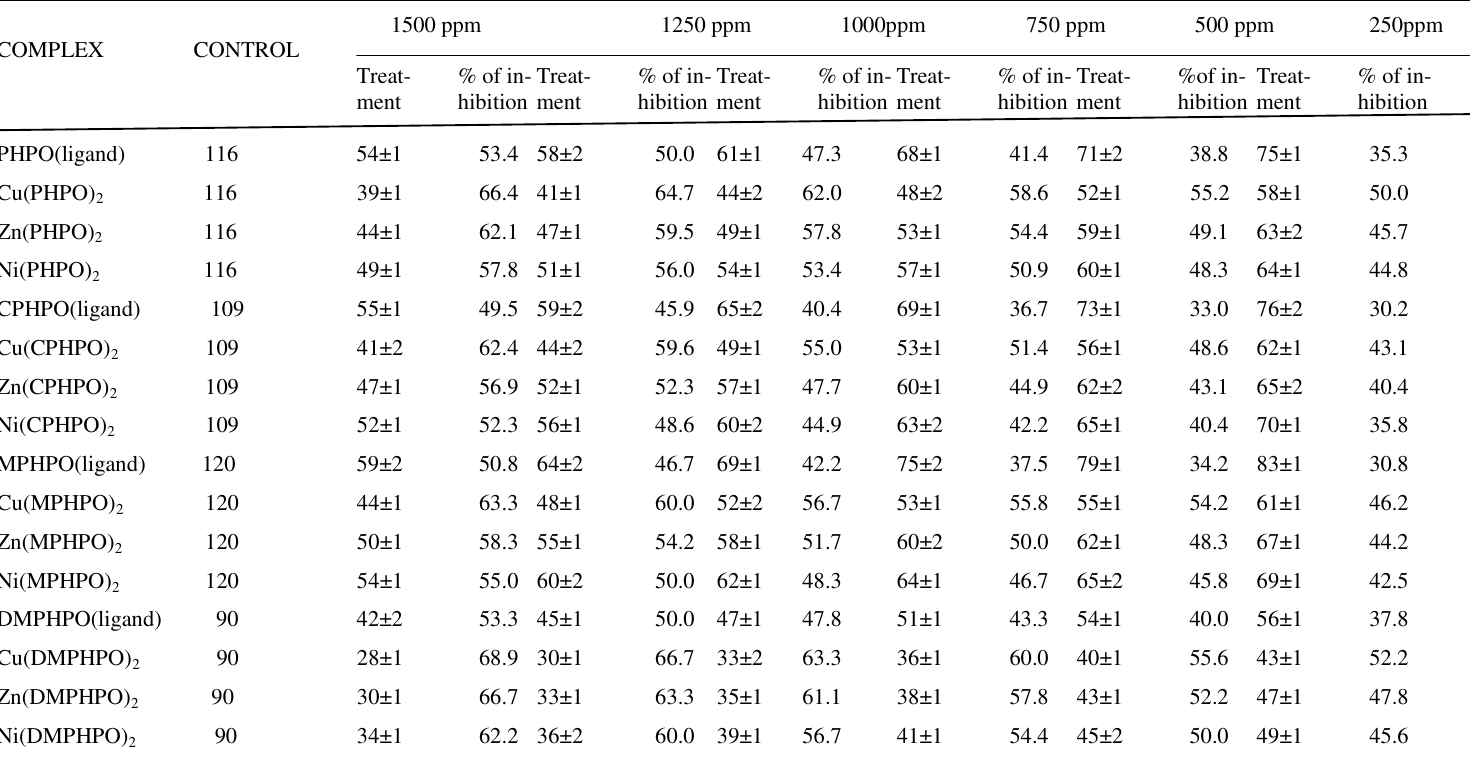
Table -1 : INFLUENCE OF Cu(II), Zn(II) AND Ni(II) COMPLEXES OF PHPO, CPHPO, MPHPO AND DMPHPO ON THE GROWTH OF VIRUS (VIGNA SINENSIS) ON COWPEA PLANT AT DIFFERENT